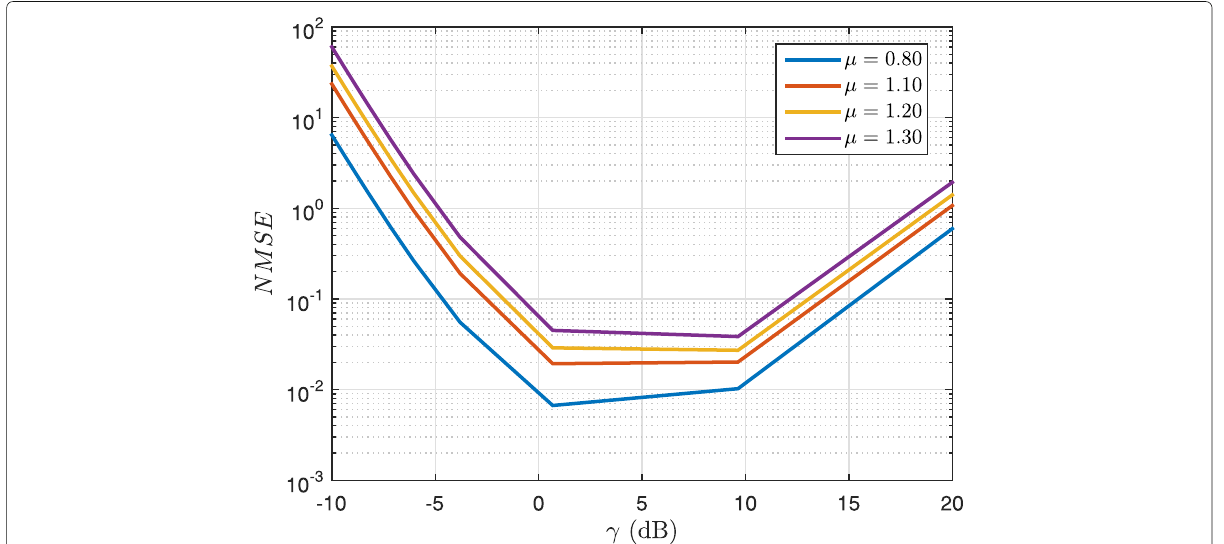
Fig. 3 NMSE of the estimate ˆ γ as a function of SNR in dB for fading η − μ with η = 0.1, different values of μ , N = 5 × 10 4 and 64-QAM modulation